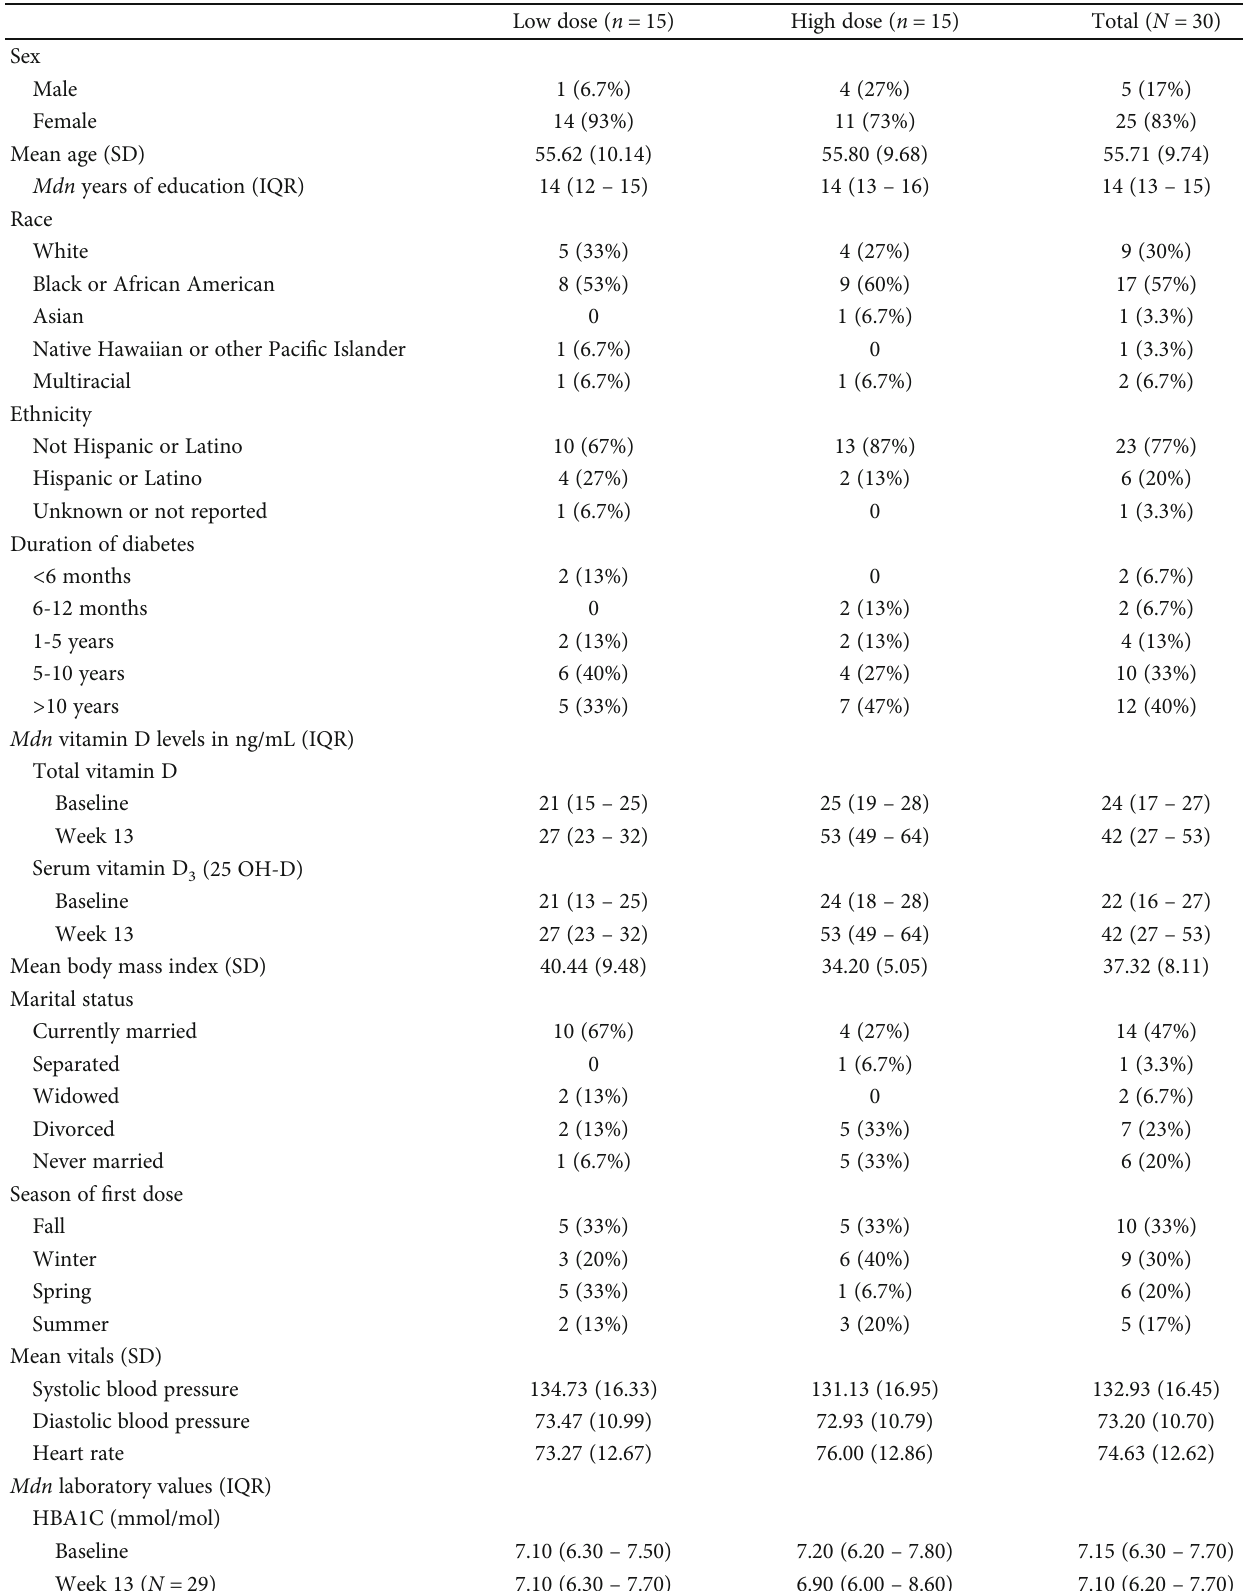
Table 1: Participant